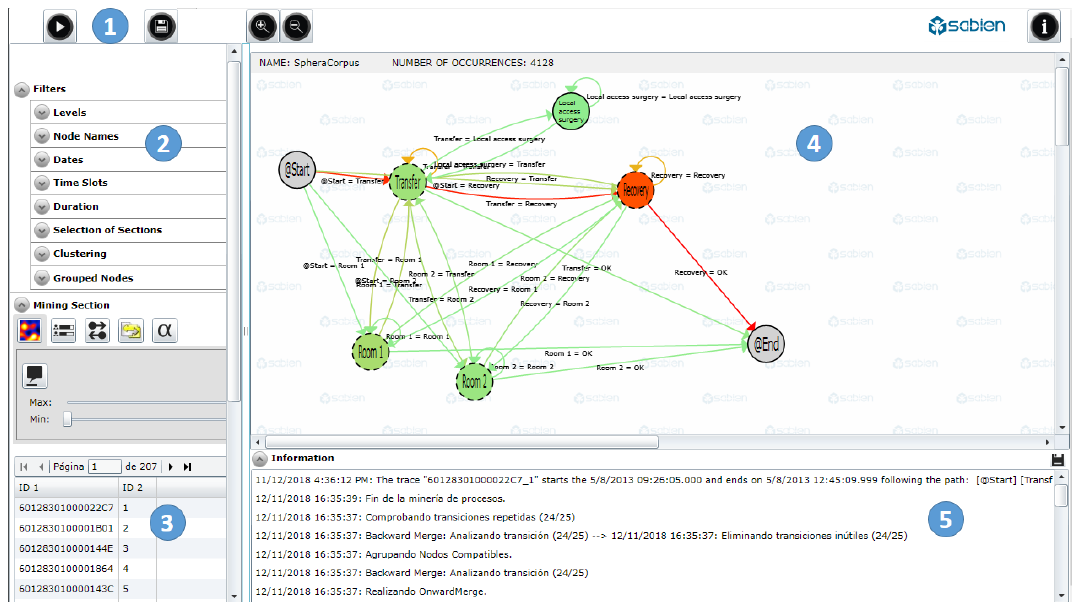
Figure 3. Areas of the process mining